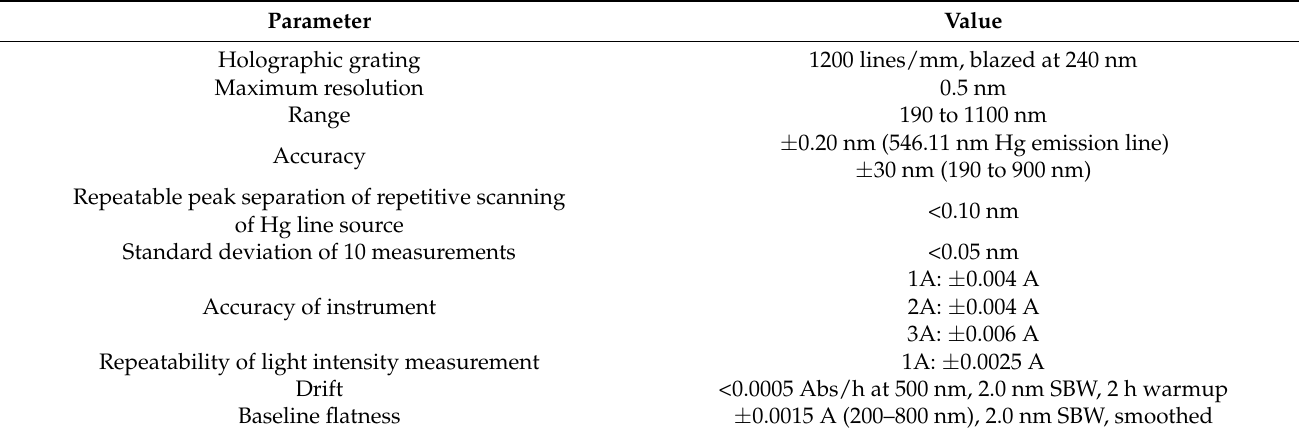
Table 1. Nicolet Evolution 300 spectrophotometer